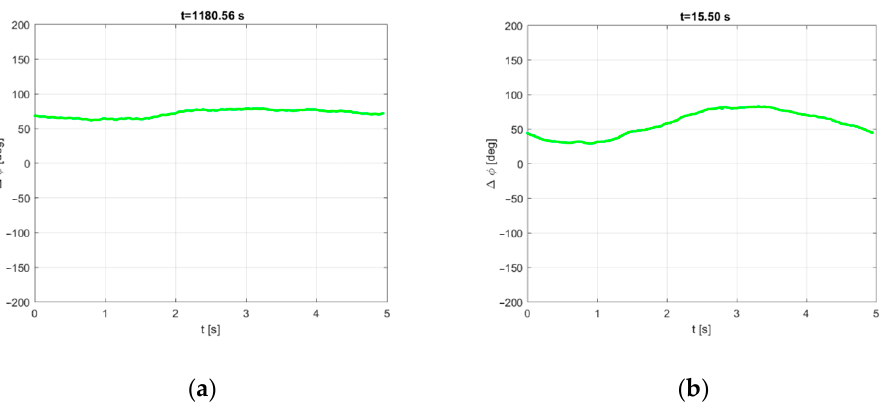
Figure 8. Surveillance/reference signals’ phase difference during calm seas ( a ) and the storm ( b ).